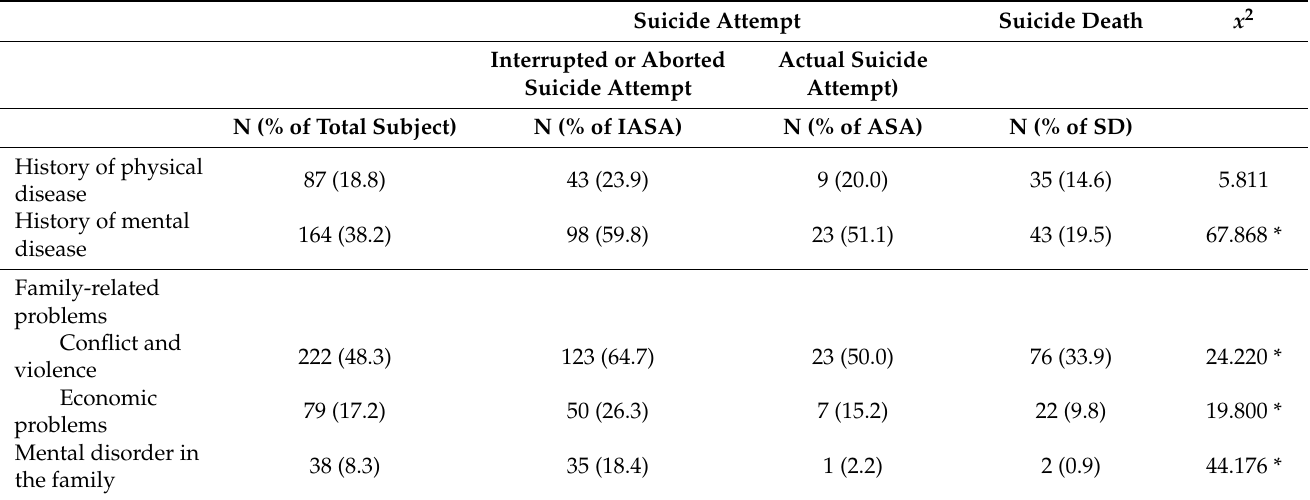
Table 4. Comparison of variables related with health and family